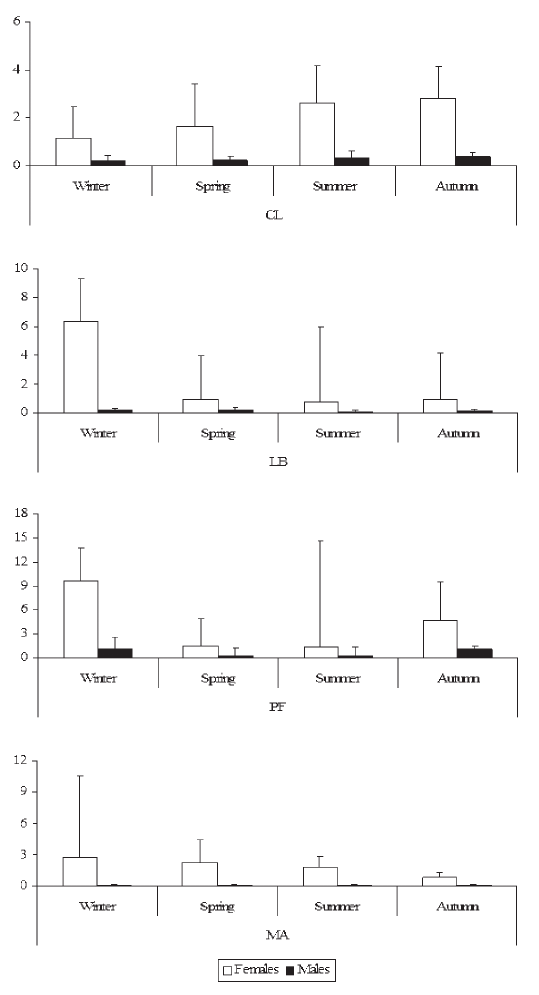
Fig . 4. – Gonadosomatic index mean values per season determined for each sex (standard deviation is represented above